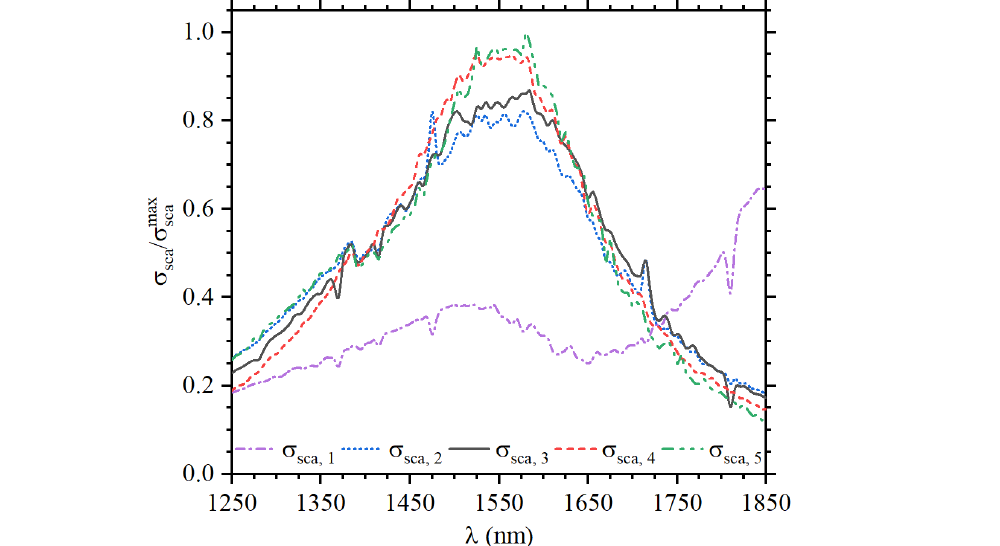
Figure 2. Comparative plot of the scattering cross-section σ sca, i (associated with Case i ) for the optimized designs. The results are normalized in relation to the maximum σ sca value, which was Case 5 in this